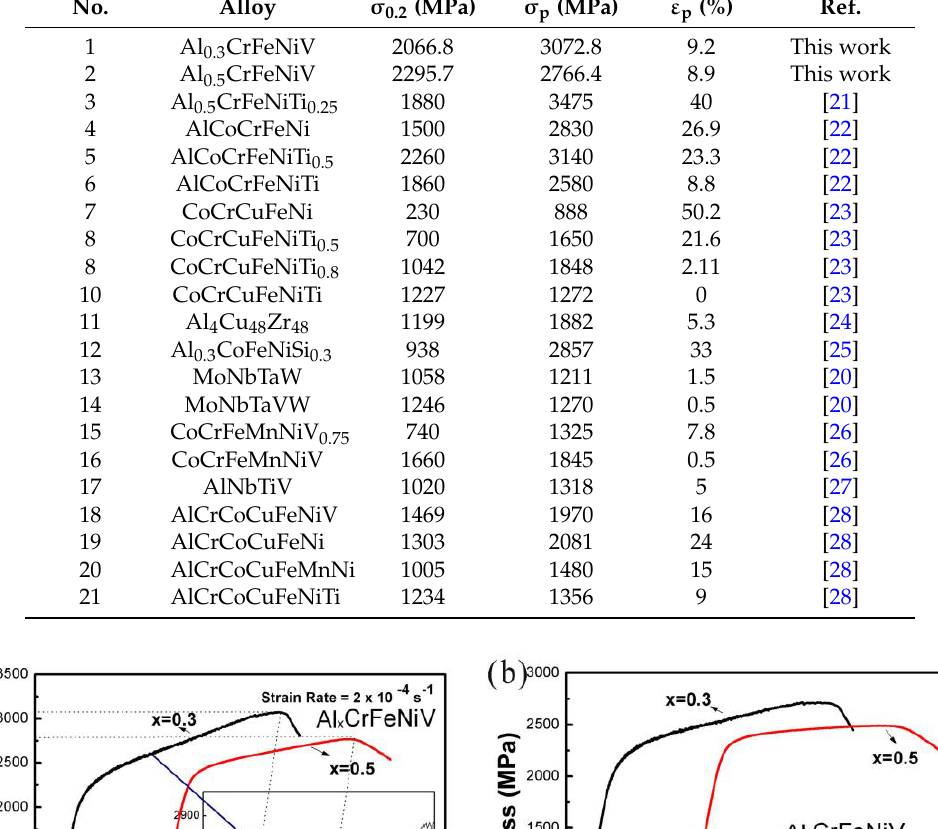
Table 2. Room temperature compression test results for the Al x CrFeNiV ( x = 0.3, and 0.5) HEAs compared with the other alloys from the material big-data.